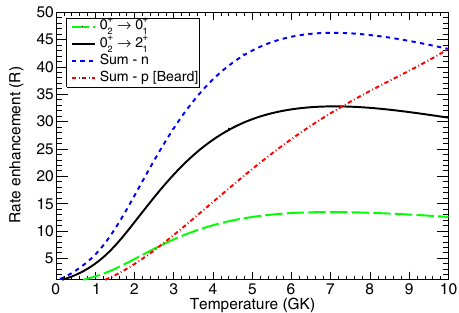
Fig. 3 Enhancement of the Hoyle radiative-width via neutron upscattering as a function of temperature. Contributions from upscattering to the 12 C ground state (green dashed) and to the 12 C fi rst-excited state (black solid). The sum of these is shown in dotted blue for a neutron density of 10 6 gcm − 3 . The comparable contribution from protons as calculated in ref. 3 is shown by the dot-dashed